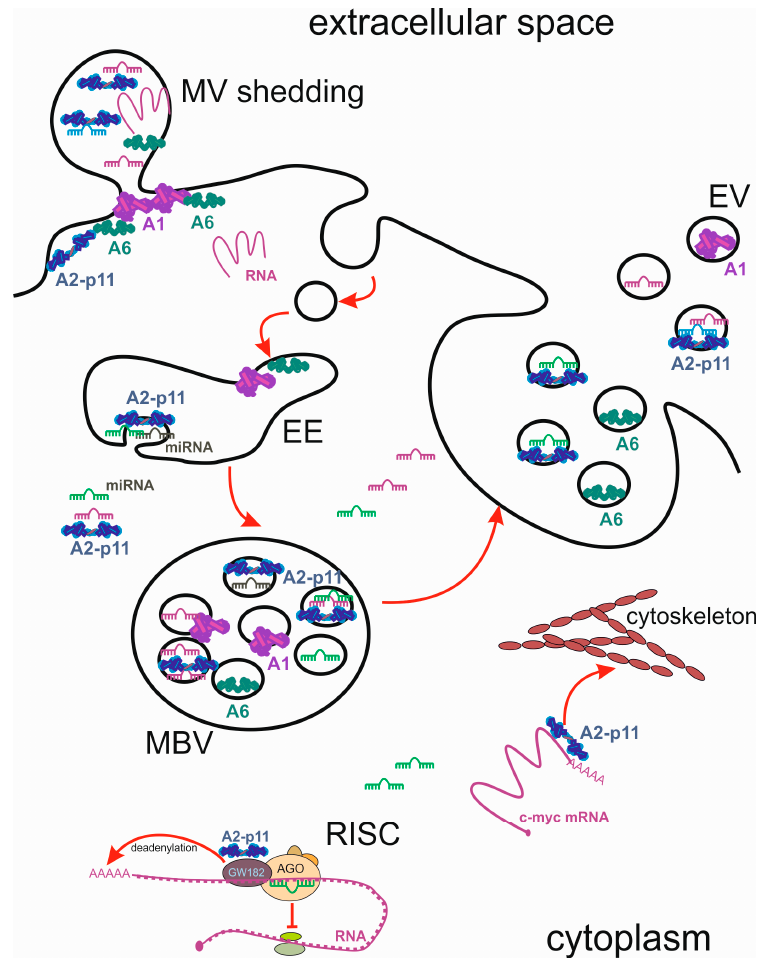
Figure 3. Annexins and regulatory RNAs in cellular compartments. Annexins associate with exosomes and shed microvesicles, and regulate RNA localisation and function. EE, early endosomes; MVB, multivesicular body; EV, extracellular vesicles; MV, microvesicle, depicted during shedding from the plasma membrane. Cellular processes (vesicle trafficking, cytoskeleton binding, deadenylation) are shown with red arrows.